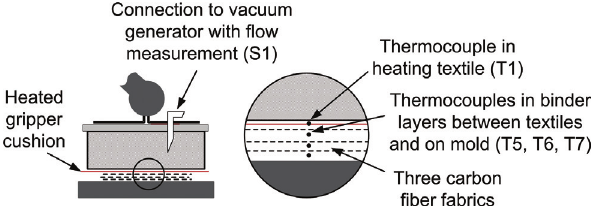
Figure 11 Experimental setup for conductive heating.